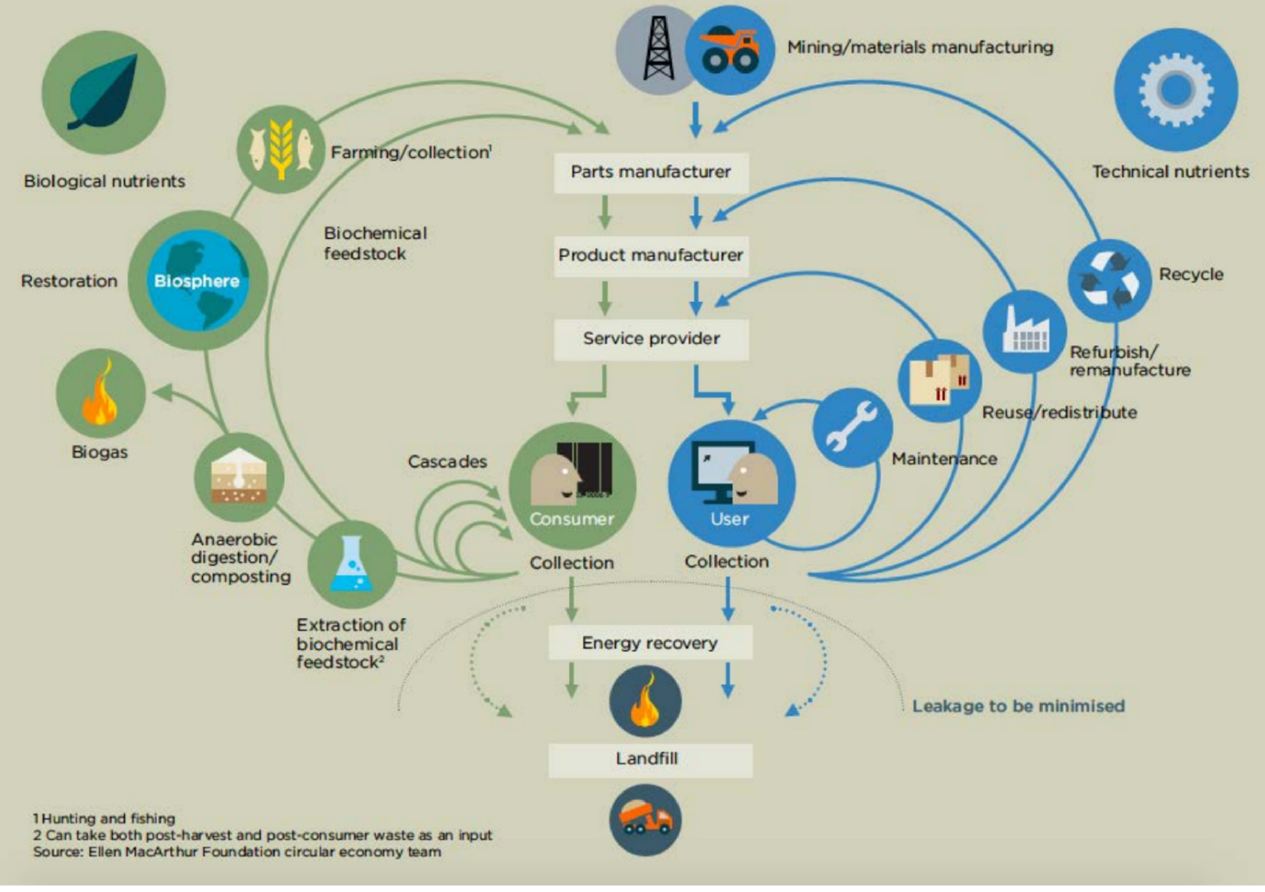
Figure 5. Illustration of cascade use within the circular economy [104].